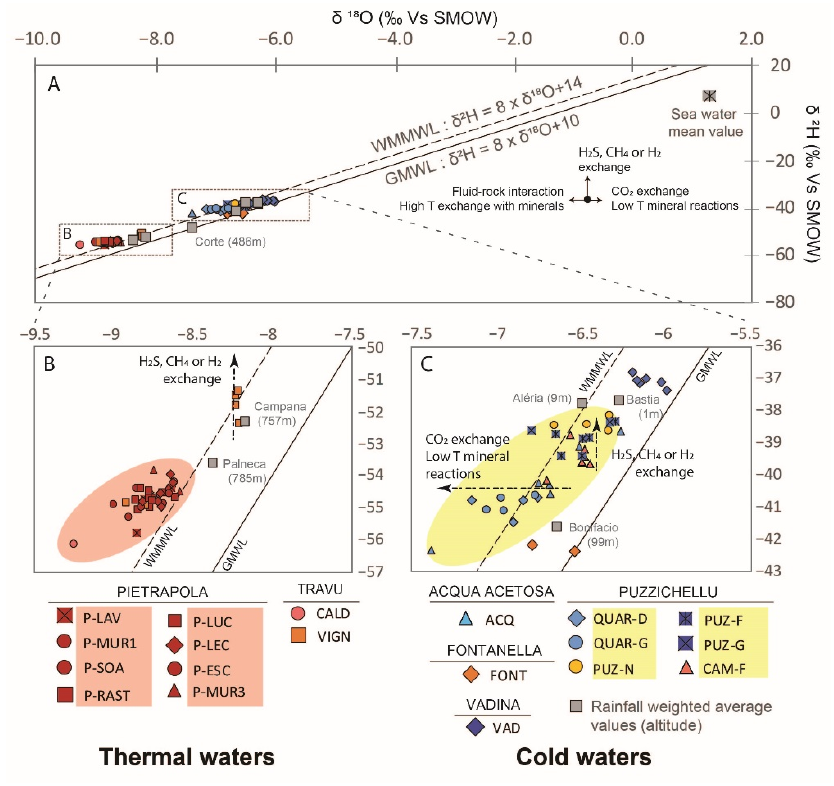
Figure 10. δ 2 H Vs. δ 18 O plot of all minerals and thermal groundwaters. The mean stable isotopic composition of the rainfall at Bastia, Aléria, Bonifacio, Campana and Palneca are also plotted as grey squares, with their respective altitude [41]. The dotted black line is the WMMWL [87] and the black line is the GMWL [86]. ( B ) and ( C ) are zoom of ( A ).